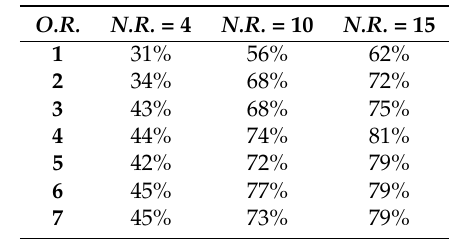
Table 2. Correctly synchronized video pairs as a function of O . R . and N . R .; σ = 1, ± ∆ R = 4, and N . C . = 3.